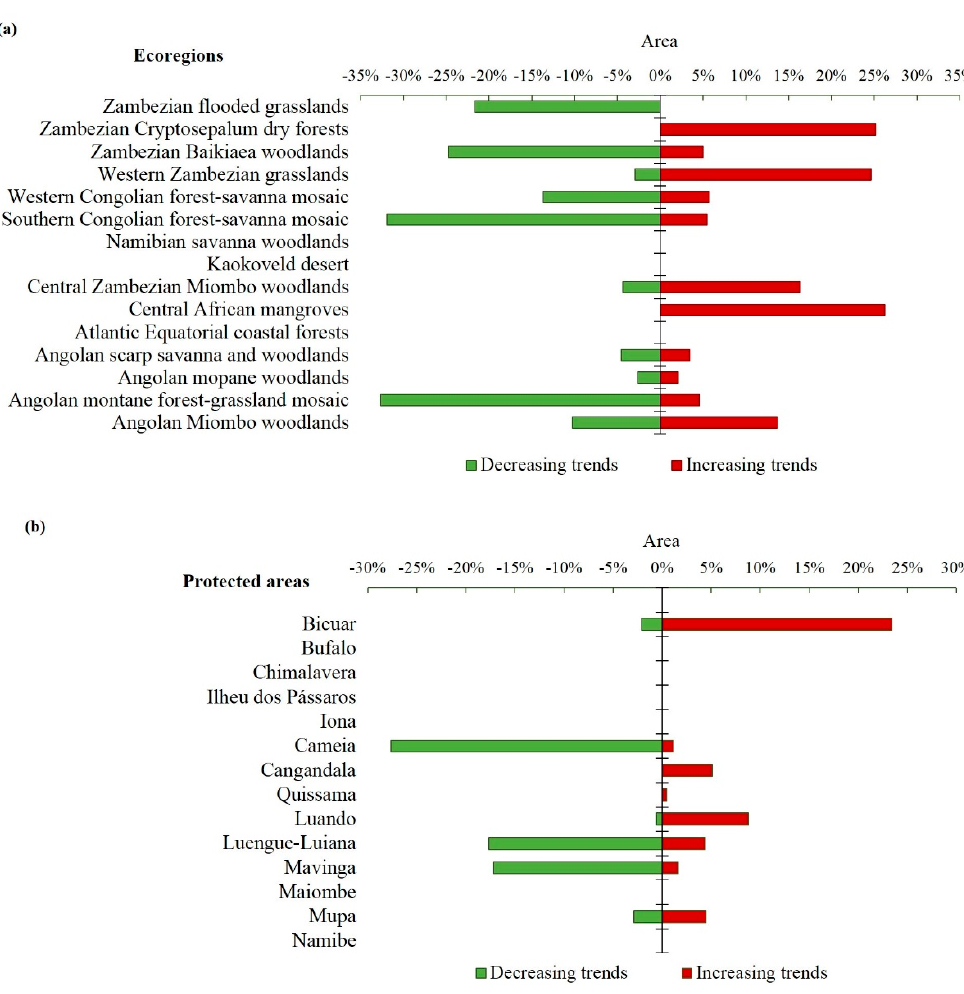
Figure 6. Areas (%) of significant increasing and decreasing trends: ( a ) in WWF ecoregions; ( b ) in protected areas.